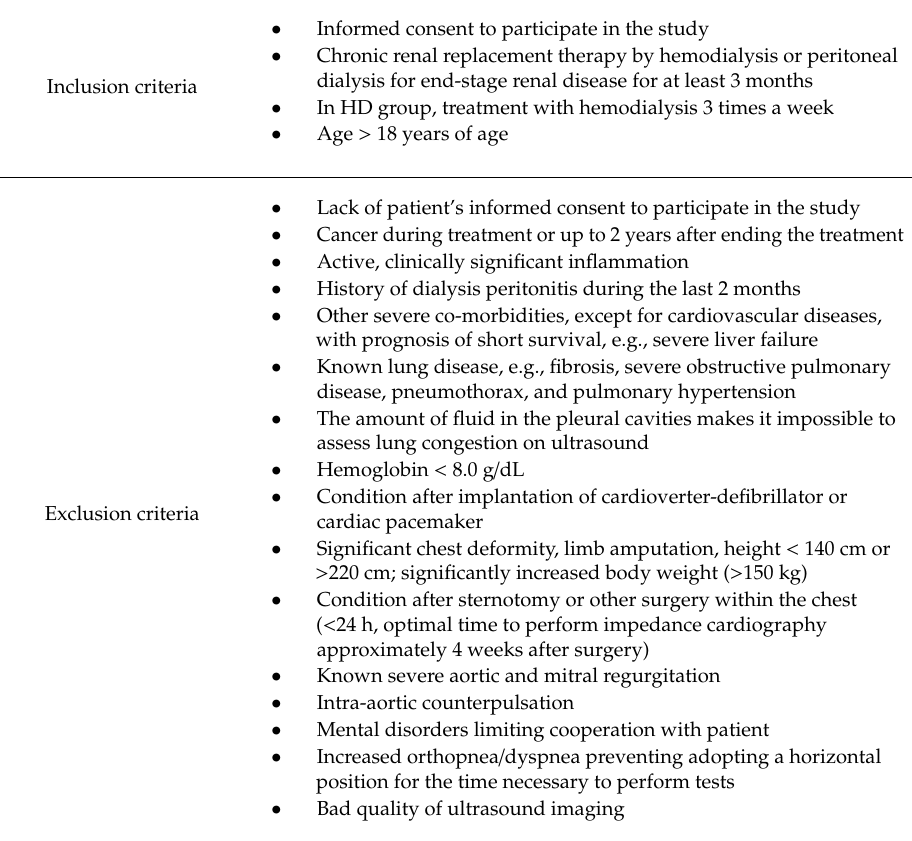
Table 1. Criteria for inclusion and exclusion in the study.